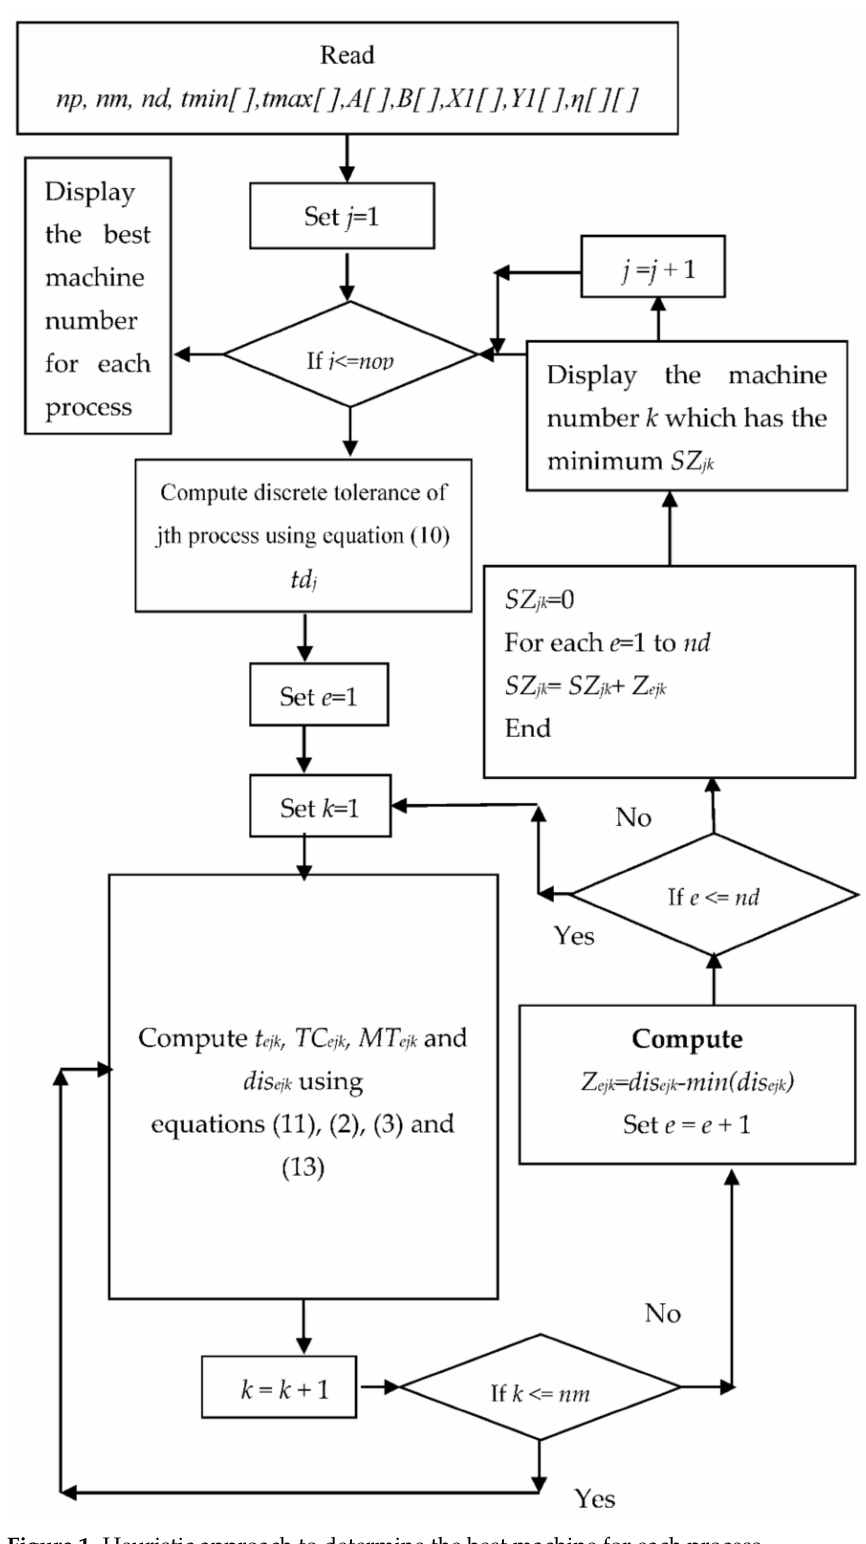
Figure 1. Heuristic approach to determine the best machine for each